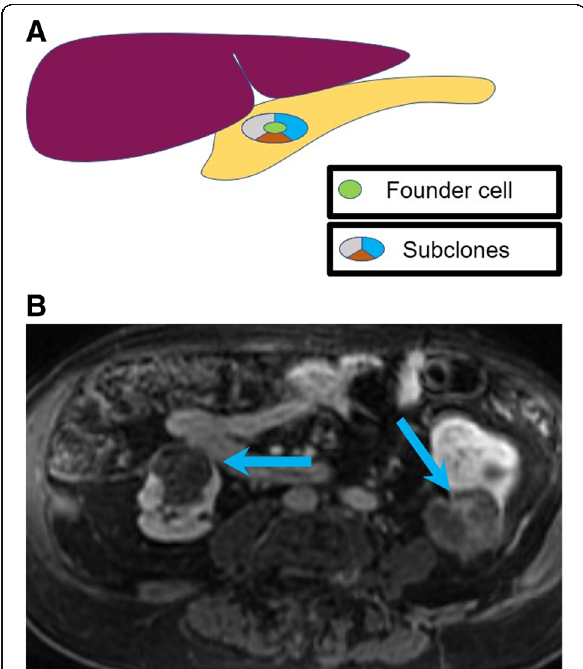
heterogeneity within the subclonal cells of a pancreatic tumor, all derived from a founder cell. b Fat-saturated T1-weighted postcontrast MRI image acquired during arterial phase showing heterogeneously appearing renal cell carcinomas (blue arrows). Mutations can be missed at tissue sampling obtained from biopsies, given the mutational heterogeneity of renal cell